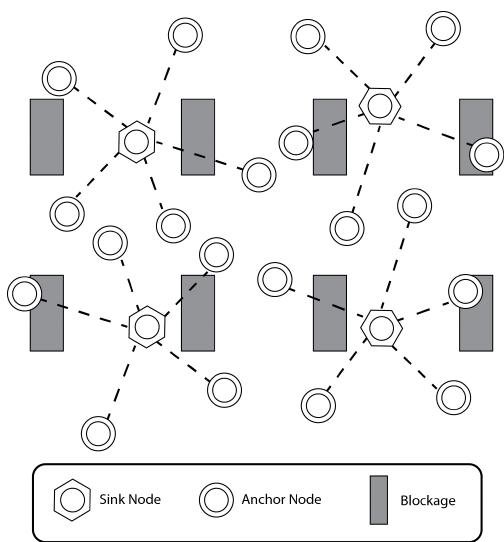
Figure 1. An industrial wireless sensor network with sink nodes and sensor